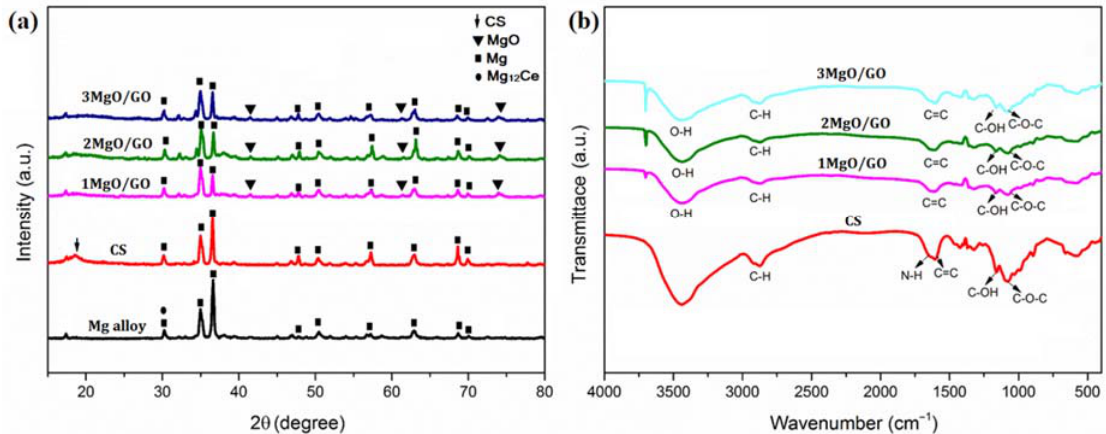
Figure 4. ( a ) XRD patterns and ( b ) FTIR analysis of CS, CS/1MgO ‐ GO, CS/2MgO ‐ GO, and CS/3MgO ‐ GO coated Mg alloys. GO coated Mg